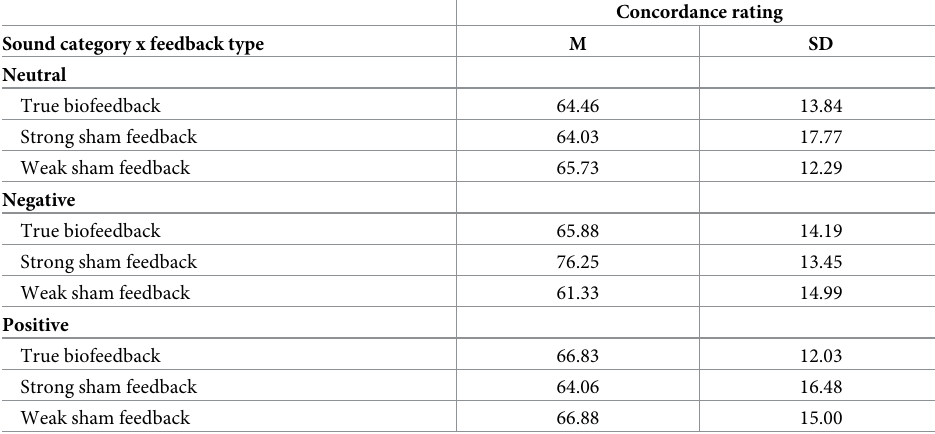
Table 2. Concordance